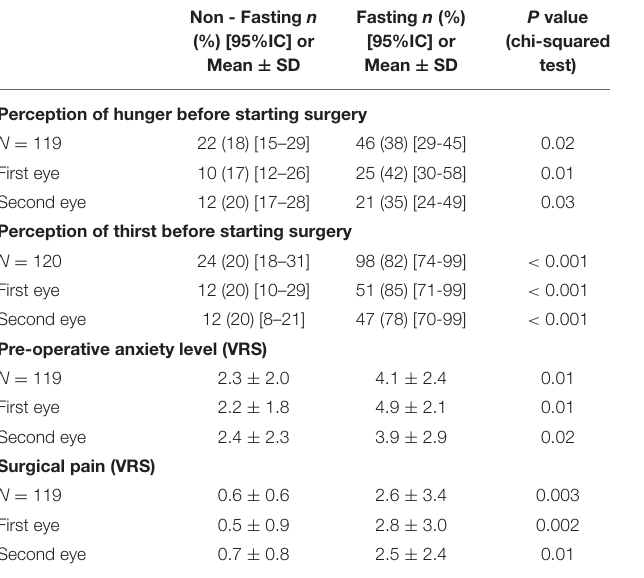
TABLE 2 | Discomfort, anxiety, and pain perception in the two